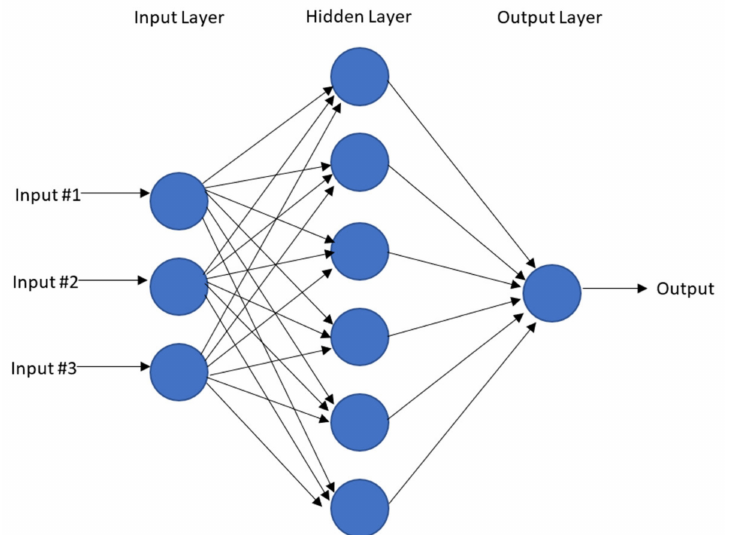
Figure 20. Neural network with one hidden